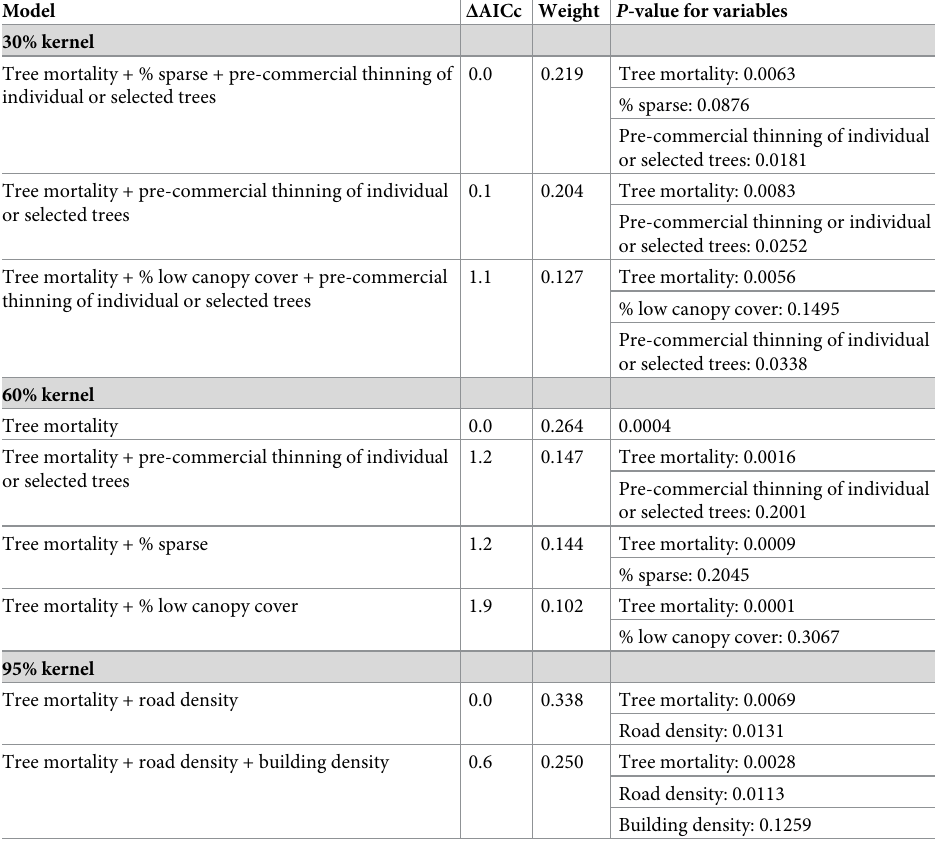
Table 3. Models with weight � 0.1 examining metrics of anthropogenic modifications, habitat, and tree mortality in the 30, 60, and 95% kernel areas of use for individual male fishers and the influence on hair cortisol levels, Sierra Nevada Mountains, California,